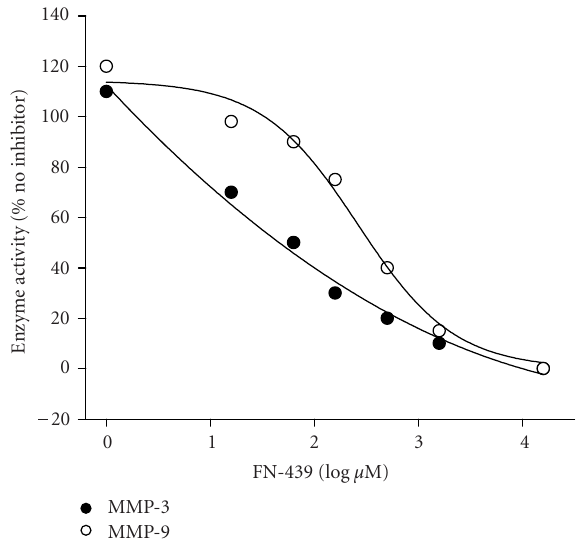
Figure 4: Results from fluorescence enzyme assays to establish the specificity of FN-439 for the catalytic domains of MMP-3 and MMP-9. The slopes were derived from the linear portion of the curves and background slopes were subtracted from all samples. The slopes were normalized as percent of enzyme activity compared with activity in the absence of inhibitor. IC 50 values were extrapo- lated using quadratic or sigmoidal curve fit programs for each sam- SEM IC 50s for MMP-3 ple and averaged. The determined mean (cid:0) 7 . 8 and 210 . 5 37 . 8 µ M. and MMP-9 were 16 . 2 (cid:0) (cid:0)